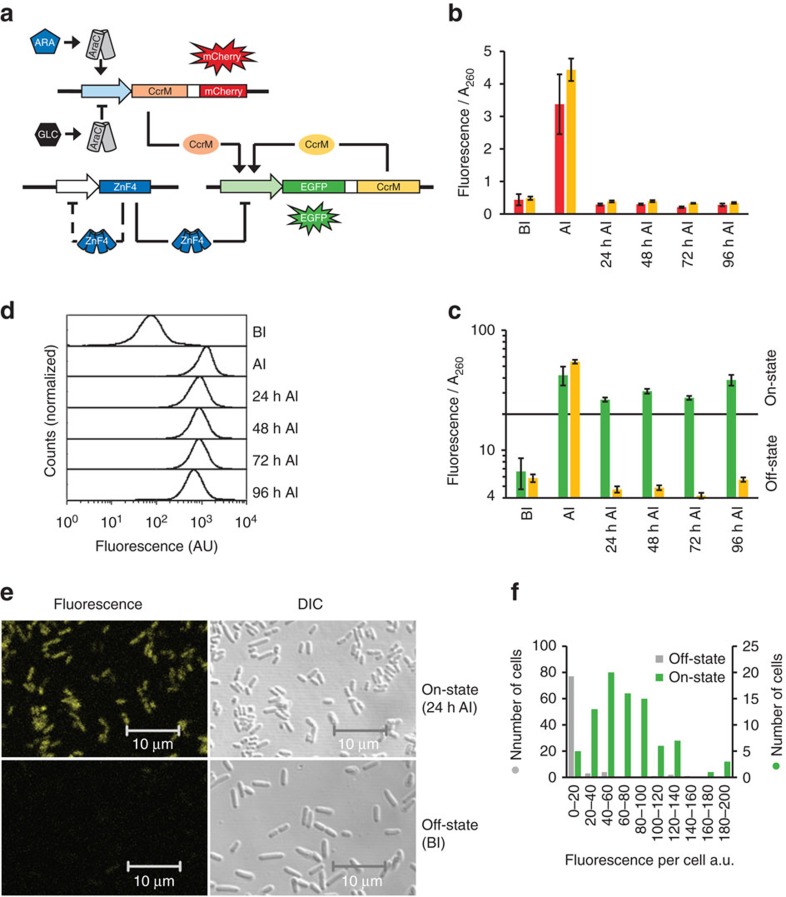
Chemical induction of memory system II by arabinose.(a) Circuit design of memory system II. In the initial off-state, glucose represses the trigger CcrM expression. The on-state is induced by arabinose supplementation, which induces CcrM and mCherry expression from the trigger plasmid. After removal of arabinose, the on-state is maintained by expression of the reporter–maintenance operon via a positive feedback loop. (b) Red fluorescent protein (mCherry) fluorescence measured in total cell lysate. Red bars: wildtype CcrM in the reporter–maintenance operon; orange bars: active site mutant CcrM in the reporter–maintenance operon (BI: before induction, that is, in glucose containing media; AI: after induction, that is, cultivation for 12 h in presence of arabinose; 24 h AI, 48 h AI, 72 h AI, 96 h AI, that is, cultivation in glucose containing media for the indicated time period after cultivation for 12 h in arabinose containing media) (error bars indicate s.d., n=3 biological repeats). mCherry signal can only be detected in the presence of arabinose. (c) EGFP signal measured in total cell lysate. On induction with arabinose, green fluorescence levels rise above the threshold level and stay in the on-state range for at least 96 h after induction (green bars). If the catalytically inactive CcrM is present in the reporter–maintenance operon, EGFP fluorescence disappears 24 h after induction and no memory function can be observed (orange bars) (error bars indicate s.d., n=3 biological repeats). (d) EGFP signal measured by flow cytometry. Cells with functional reporter–maintenance operon (that is, wildtype CcrM) were analysed. Histograms depict homogeneous populations in the off- and on-state. 20,000 events were collected for each measurement. (e) Confocal laser scanning microscopy pictures and differential interference contrast (DIC) microscopy pictures of cells with functional reporter–maintenance operon in the on-state (24 h AI) and cells in the off-state (BI). (f) Quantification of fluorescence intensities of cells in the on-state and in the off-state recorded by confocal laser scanning microscopy (n=87, per state). For statistical analysis of the results shown in b,c, see Supplementary Table 2.